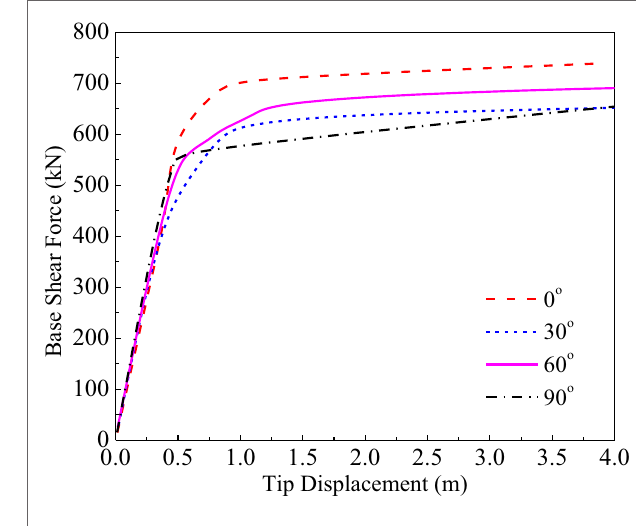
FigUre 13 | capacity curves for the four wind directions . FigUre 12 | capacity curve for longitudinal direction ( β = 0°)